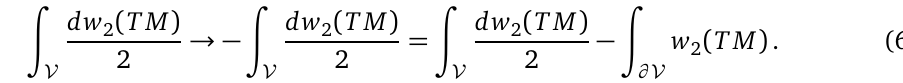
Figure 6: Interface on the membrane operator one side of the interface. We use the ordering convention in the product of operators such that the operators that are diagonal in the Z eigenbasis (the Z and CZ operators in the figure) appear on the right of the X operators, and the product takes the form (cid:81) (cid:81) (cid:81) X Z CZ